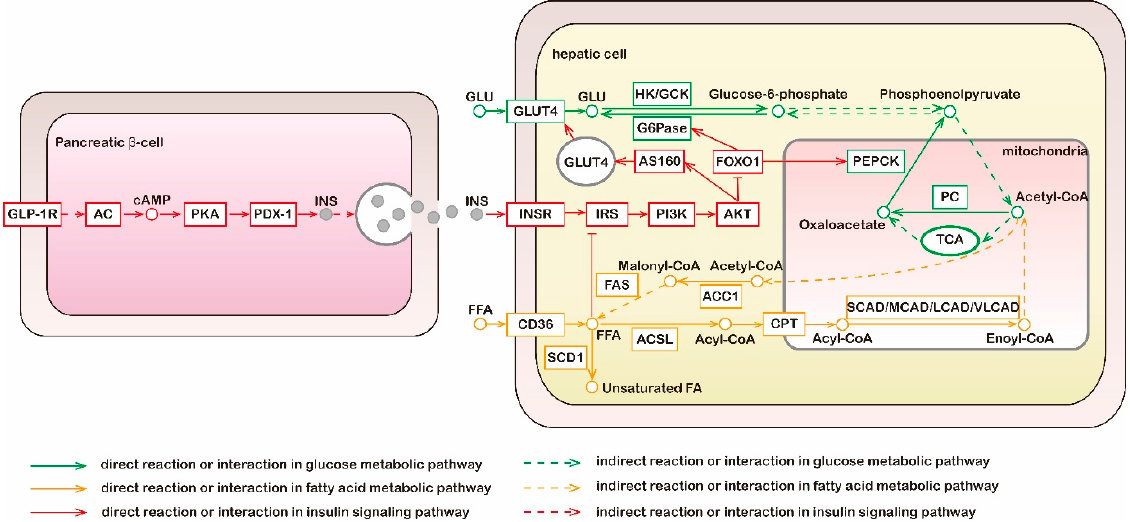
Figure 1. Metabolic and signaling pathways of glucose, fatty acid, and insulin. Liver is the main organ of gluconeogenesis; liver and adipose tissue are main sites of fatty acid synthesis; the above two metabolic pathways do not occur in muscle tissue. Green lines, molecular interaction or relation in glucose metabolic pathway; yellow lines, molecular interaction or relation in fatty acid metabolic pathway; red lines, molecular interaction or relation in insulin signaling pathway; dotted lines, indirect reaction or interaction. GLP-1R, glucagon-like peptide 1 receptor; AC, adenylate cyclase; PKA, protein kinase A; PDX-1, pancreatic and duodenal homeobox 1; INS, insulin; GLU, glucose; GLUT4, glucose transporters 4; HK, hexokinase; GCK, glucokinase; G6Pase, glucose-6-phosphatase; TCA, tricarboxylic acid cycle; PC, pyruvate carboxylase; PEPCK, phosphoenolpyruvate carboxykinase; INSR, insulin receptor; IRS, insulin receptor substrates; PI3K, phosphatidylinositol 3-kinase; AKT, protein kinase B; SCD1, stearoyl-CoA isomerase 1; FFA, free fatty acid; ACSL, long-chain acyl-CoA synthetase; CPT, carnitine palmitoyl transferase; CAD, acyl-CoA dehydrogenases; ACC1, acetyl-CoA carboxylase 1; FAS, fatty acid synthase. Table 1. Effect of puerarin on glucose and lipid